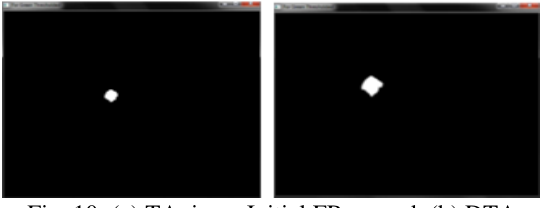
Fig. 10: (a) TA in an Initial FR img and (b) DTA after moving the hand towards the camera (Forward Movement)